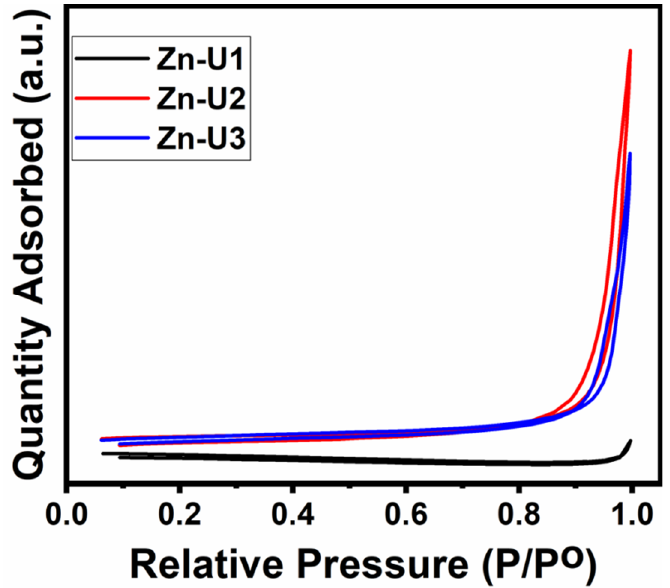
Figure 6. N2-adsorbtion and desorption curves. Table 1. The surface properties of the catalysts were examined by BET surface area.